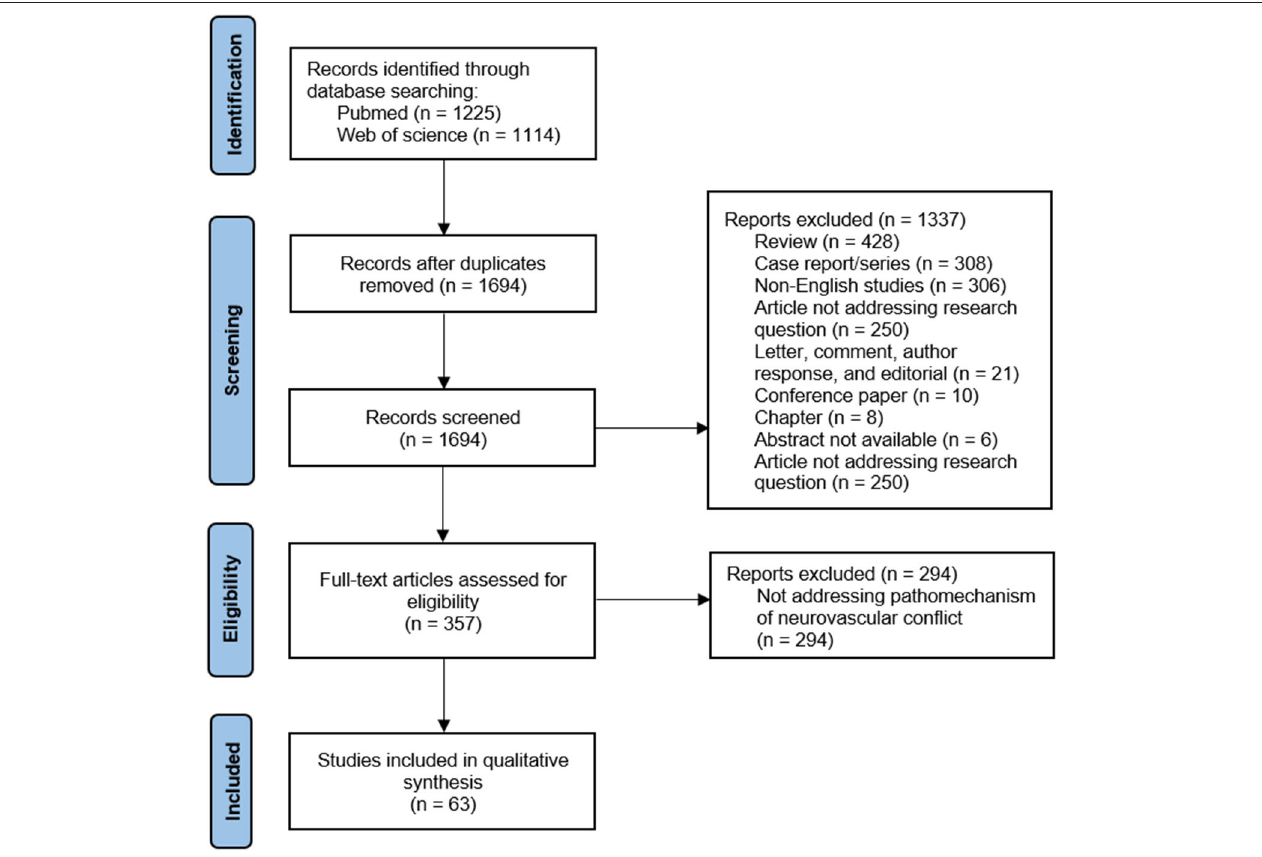
FIGURE 1 | The flow-chart of publications included